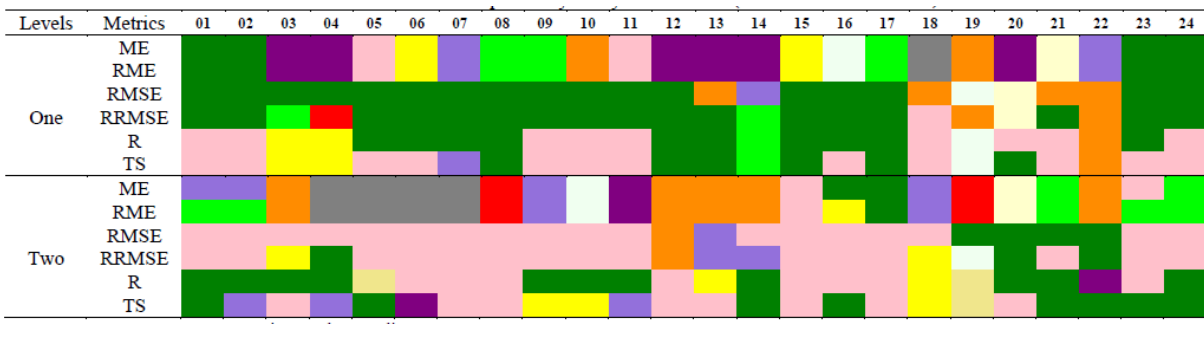
Table 12. Same as Table 5 but MOD16A2 replaced by the synthesized ET (cell colors as in Table 13).